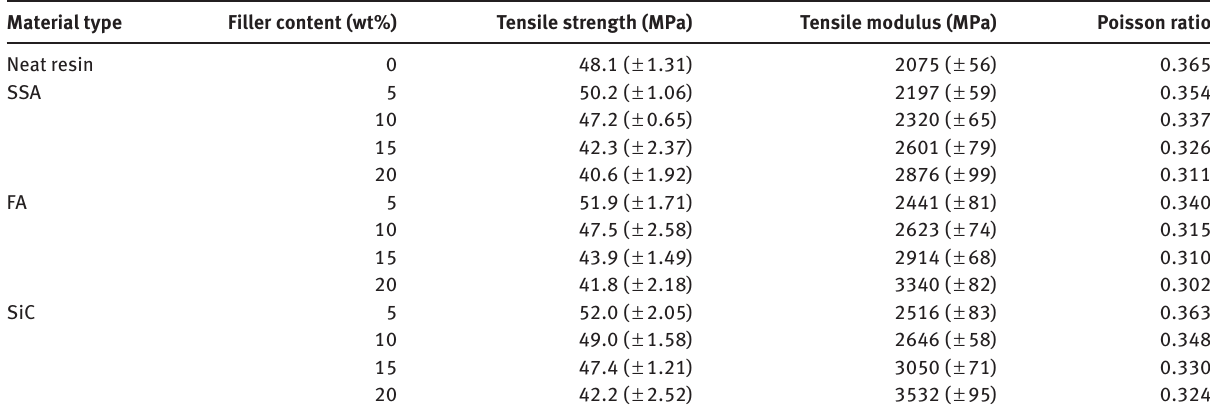
Table 3: Tensile properties of the particulate polymer composites. Material